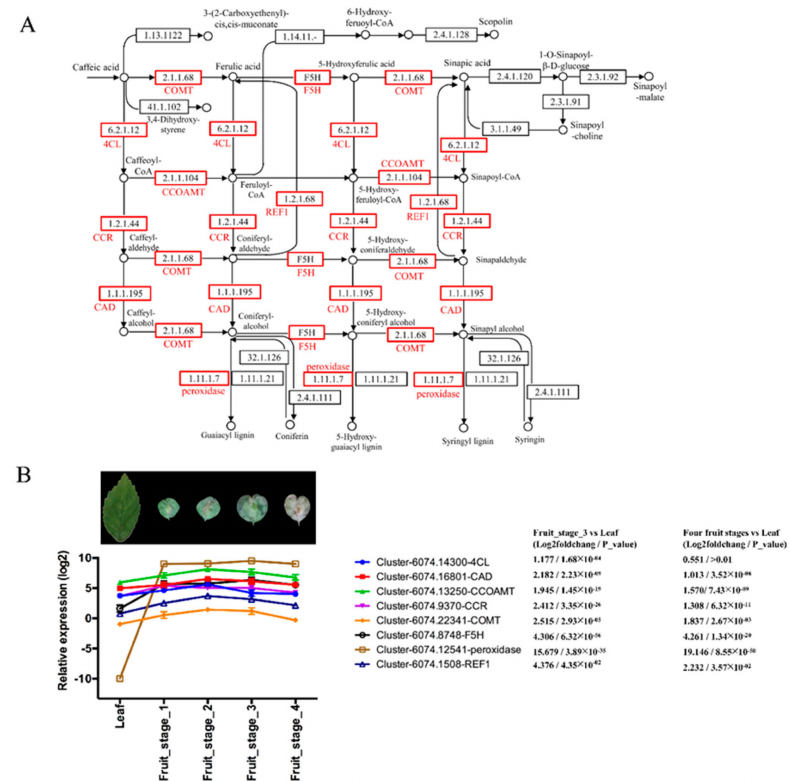
Figure 4. ( A ) The upregulated unigenes were mapped to lignin / Coniferin / Syringin metabolism in “phenylpropanoid biosynthesis” (ko00940) based on the KEGG database. The significantly upregulated genes in ko00940 are labeled with a red border. ( B ) Gene expression patterns of eight key genes were obtained by qRT-PCR analysis in young fruits (fruit stage 1–2), ripe fruit (fruit stage 3), old fruit (fruit stage 4), and leaves. The Log 2 () fold change and p -value were listed for dysregulated unigenes in fruit stage 3 and four fruit stages compared with that of